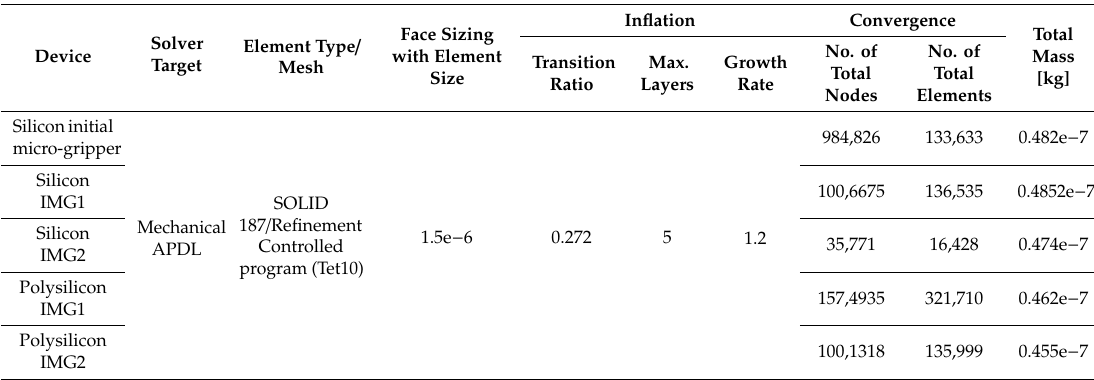
Table 9. Technical details about FEA.